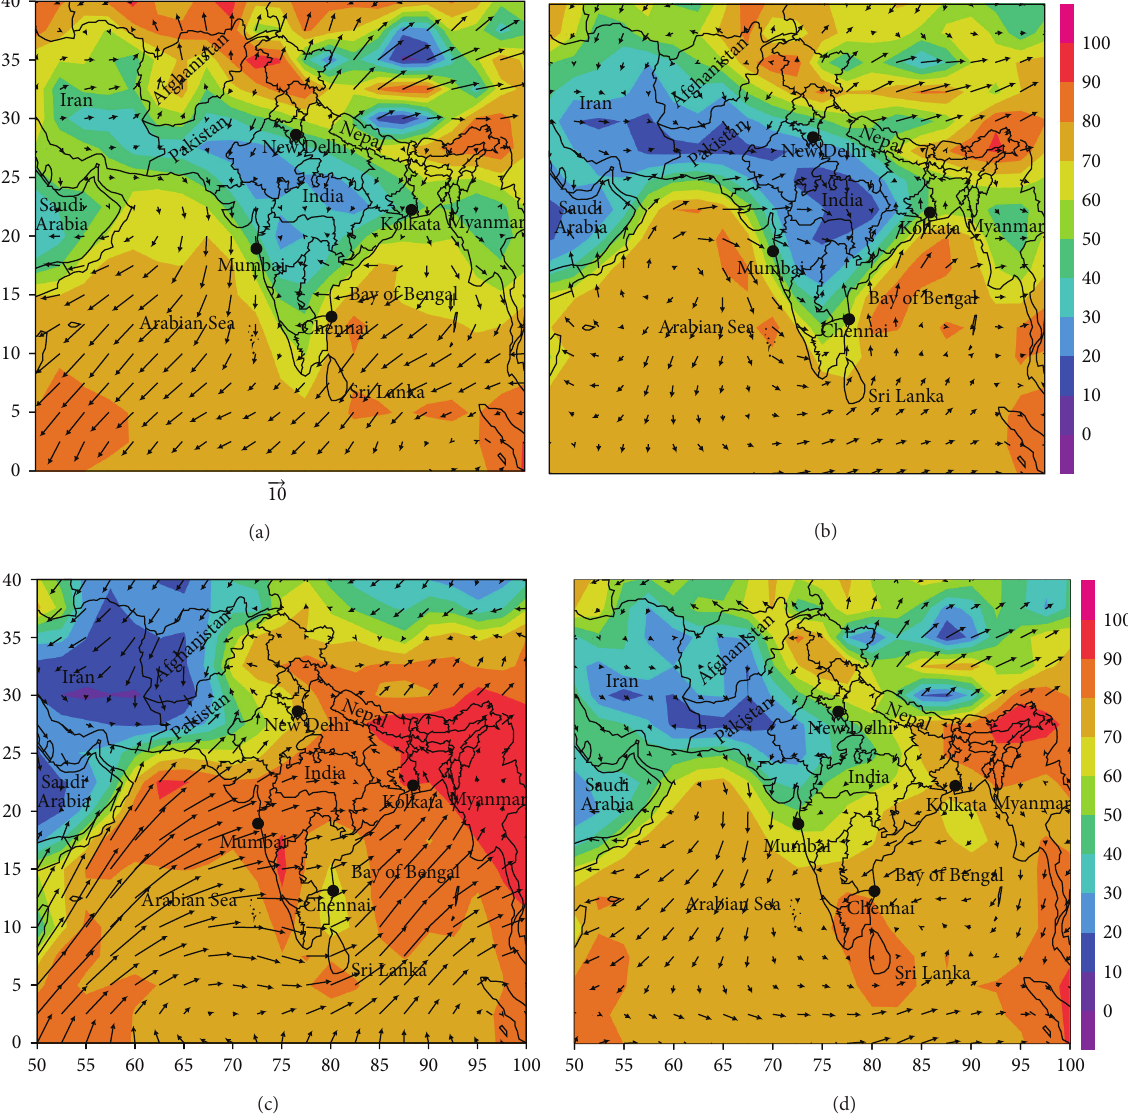
Figure 2: Surface level relative humidity (%) and synoptic winds (ms −1 ) over the Arabian Sea, India, and the Bay of Bengal during (a) winter (DJF), (b) premonsoon (MAM), (c) monsoon (JJAS), and (d) postmonsoon (ON). The shaded contours correspond to relative humidity, on which winds represented by arrows are